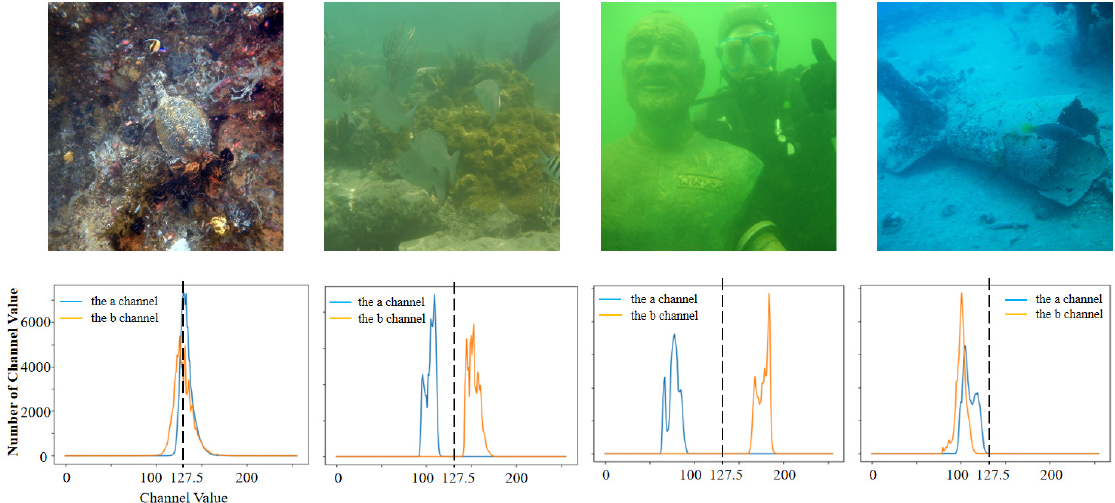
Figure 3. Underwater images and their gray histograms of color channels. The blue polyline represents the a channel, and the orange polyline represents the b channel.